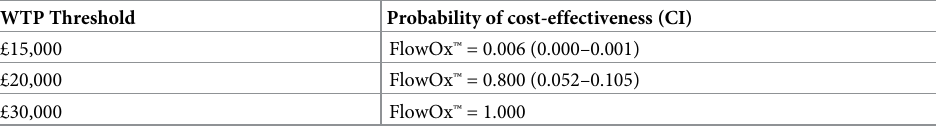
Table 10. Probabilities and confidence intervals of cost-effectiveness at different WTP thresholds (all ages).